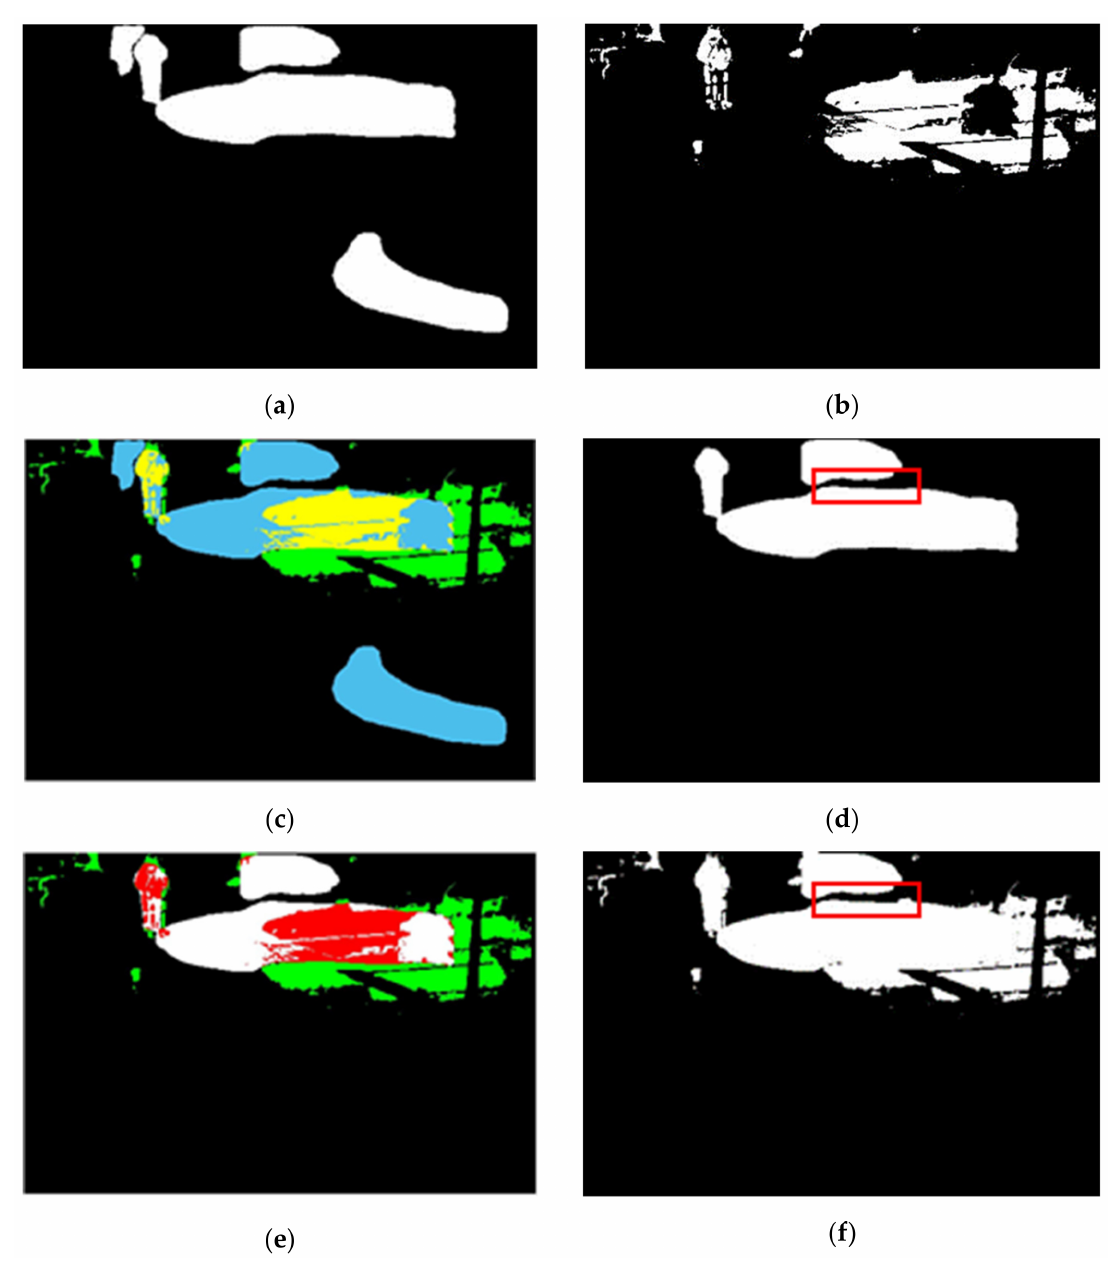
Figure 10. Results after fusing data of the Mask R-CNN model and the TA model for the video sequence “Traffic”, frame 79. Red circle ( a ) Mask R-CNN object mask ( b ) TA object mask ( c ) Predicted object pixels of both models (blue and green) including common pixels (yellow) ( d ) Selected clusters ( e ) Integration of selected clusters and predicted pixels of TA model. Additionally, ( f ) Predicted object mask after